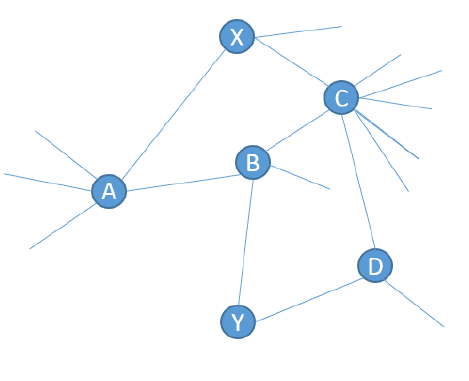
Figure 1. A simple undirected